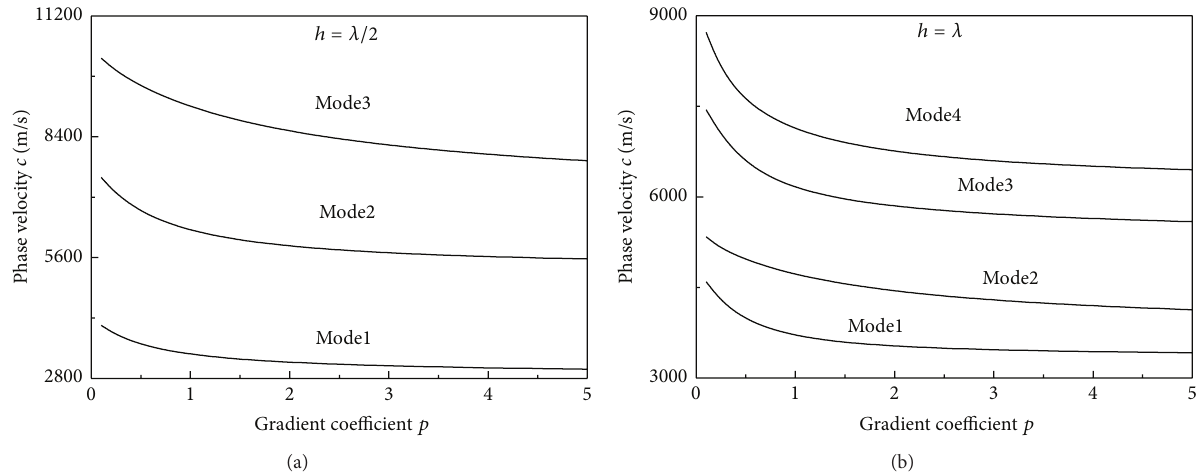
Figure 4: Phase velocity plotted as functions of gradient coefficient 𝑝 . (a) Thickness of the plate equals half a wavelength. (b) Thickness of the plate equals a wavelength.